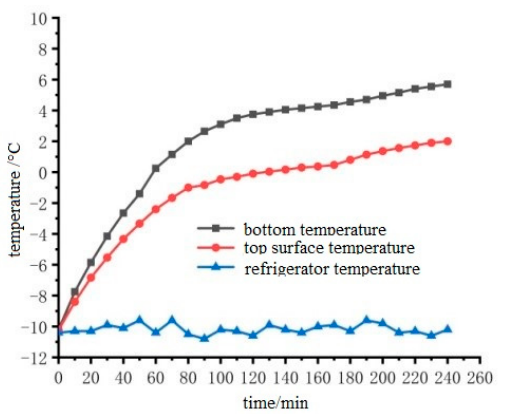
Figure 19. Temperature rise diagram of cast conductive asphalt concrete slab with thermal insula- tion layer.